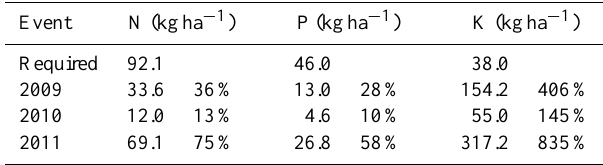
Table 5. Nutrient requirements for a rice crop in the wet season, delta-wide mean nutrient supply from flood events to floodplains, and percentage of required nutrients supplied by flood